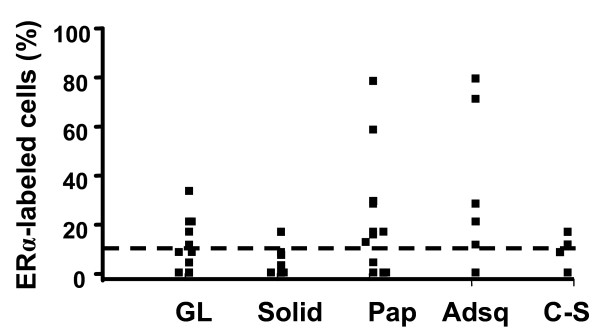
Mammary carcinomas that develop in NRL-PRL females exhibit diverse histotypes, and express varying levels of ERα. The proportion of cells containing immuno-detectable ERα was quantitated as described in Materials and methods, and shown related to tumor histotype. Each box represents a single tumor that arose in a different NRL-PRL nonparous female. The dashed line marks 10% ERα+ cells, a common clinically used threshold. (Tumor histotypes: GL, glandular; Pap, papillar; Adsq, adenosquamous; C-S, carcinosarcoma).